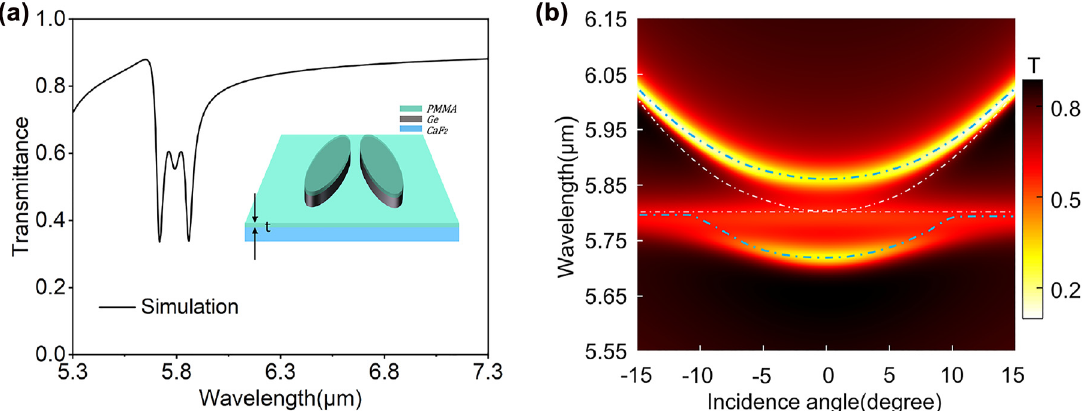
Figure 4: Generation of strong coupling and properties of the hybridization states. (a) Calculated transmission spectrum at normal incidence when a PMMA layer with the thickness of 78 nm is used. The strong coupling with resonance splitting phenomenon can be well observed. The inset illustrates a schematic diagram of the structure after spin-coating a thin layer of PMMA on top, where t represents the thickness of the PMMA layer. (b) The dispersion diagram calculated with the presence of the PMMA thin film ( t = 78 nm). index of PMMA molecules while eliminating its